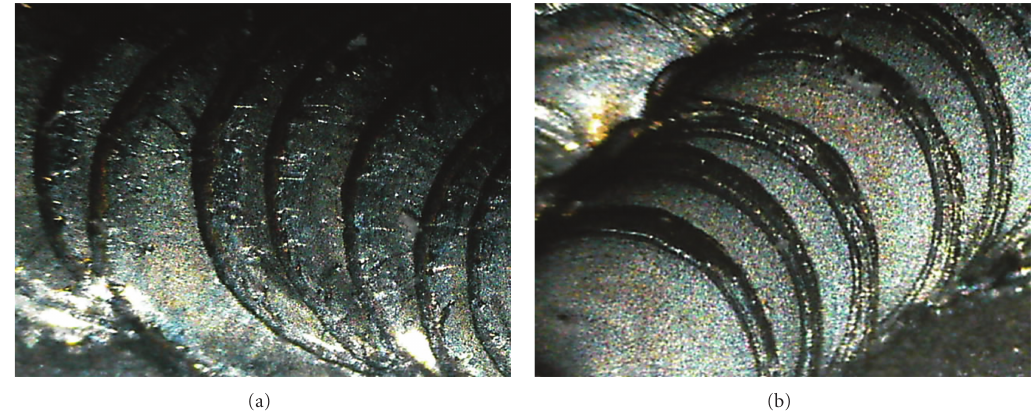
Figure 5: Microscopic vision of group A (a) and group B (b) laser welded plates.